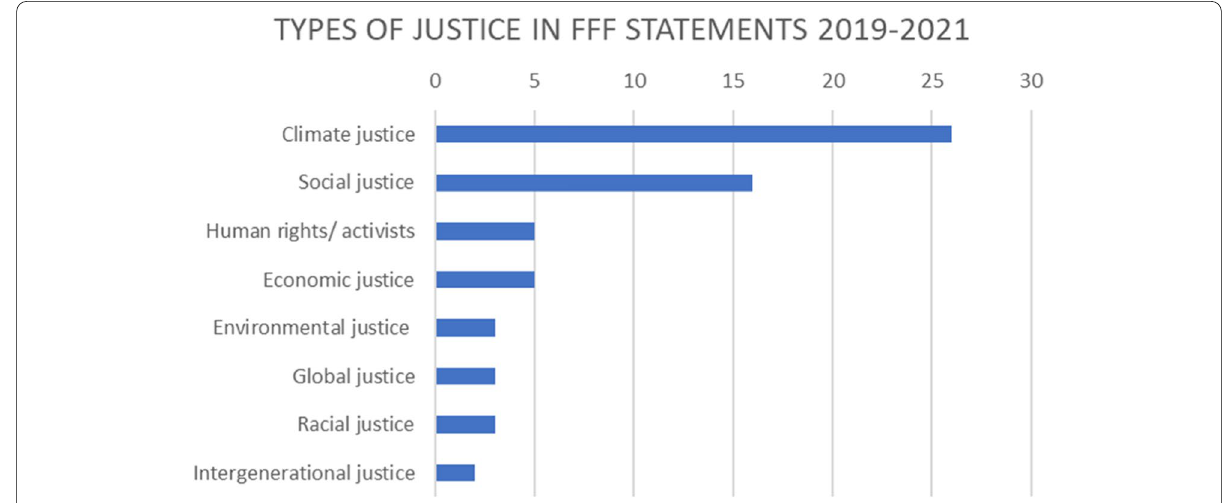
Fig. 2 Types of justice in FFF statements